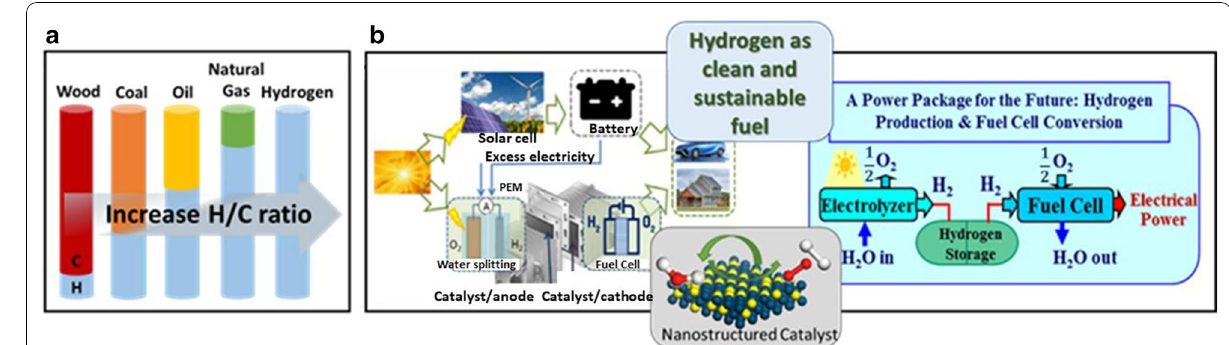
Fig. 1 a An illustration of the evolution of fuels in terms of hydrogen to carbon ratio. b Illustrations of a dual cell functioning as an electrolysis water splitting cell for hydrogen production from solar energy and a fuel cell for the conversion of hydrogen to electricity, highlighting the sustainable power package of the future and the role of